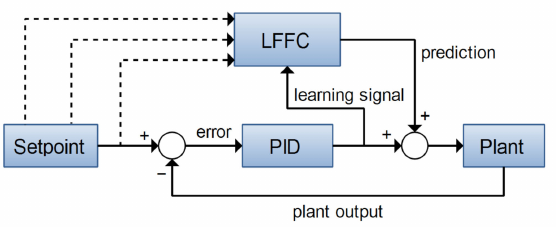
Figure 1. Basic scheme for a learning feedforward